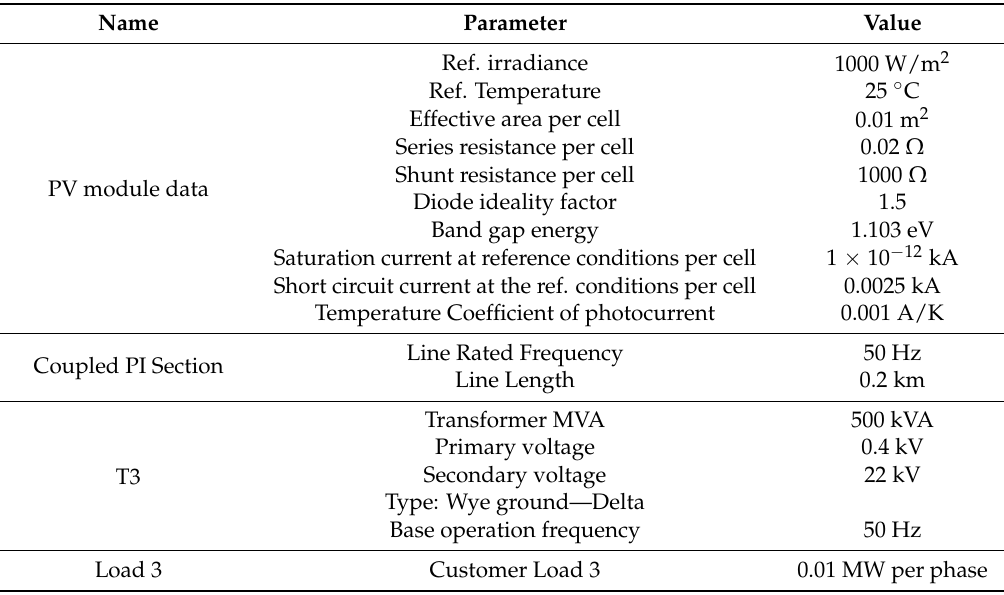
Figure 12. The series LC ferroresonance circuit for Cases II and III. Table 2. The parameters for simulation Cases II and